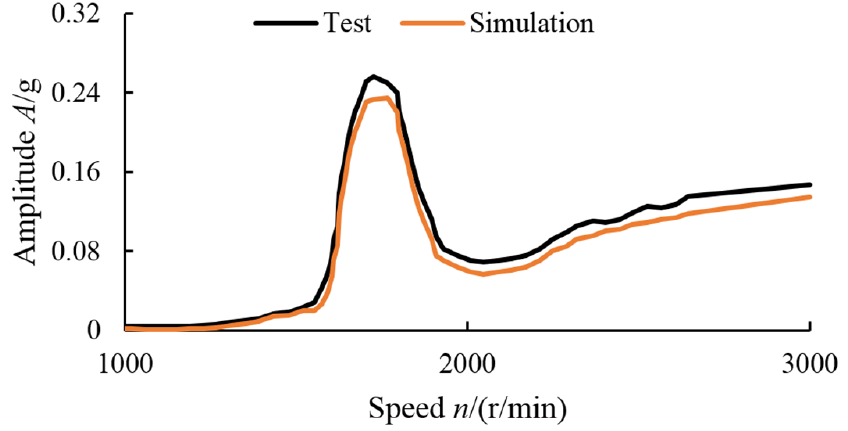
Figure 7. The test rig for response.